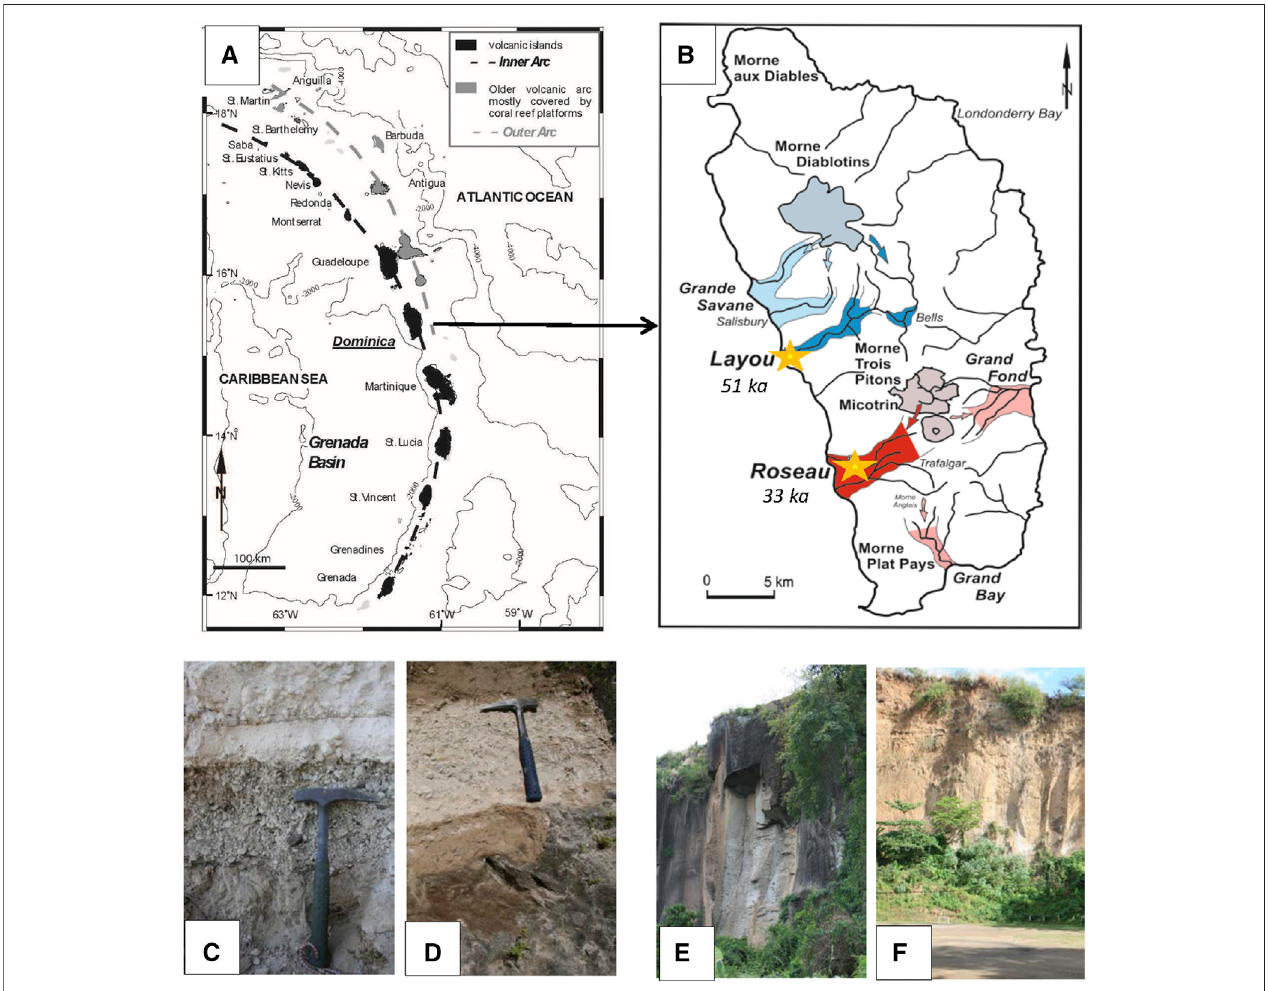
FIGURE1| Dominicaandstudiedignimbriticeruptions. (A) LesserAntillesarc,withDominicainthecentralpartofthearc. (B) Dominicaandlocationofthesampled outcrops (stars) for Layou and Roseau ignimbrites, after Boudon et al. (2017). Red: deposits from Morne Trois Pitons – Micotrin eruptive center, with dark red deposits corresponding to Roseau eruption. Blue: deposits from Morne Diablotins eruptive center, with dark blue deposits corresponding to Layou eruption. (C) Layou Plinian fallout deposit. (D) Roseau fallout deposit. (E) Layou pyroclastic density current deposit. (F) Roseau pyroclastic density current deposit.